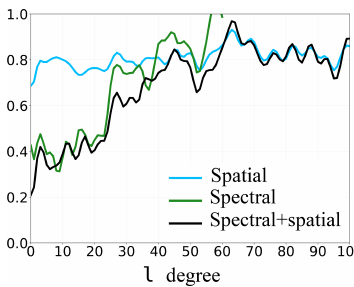
Figure 7. Reduction of spatial RMSE for each degree for the SSH, computed using Eq. (14). The blue curve (spatial) refers to the spa- tially updated ensemble, the green curve (spectral) to the spectrally updated ensemble and the black curve (spectral + spatial) to the multiscale updated